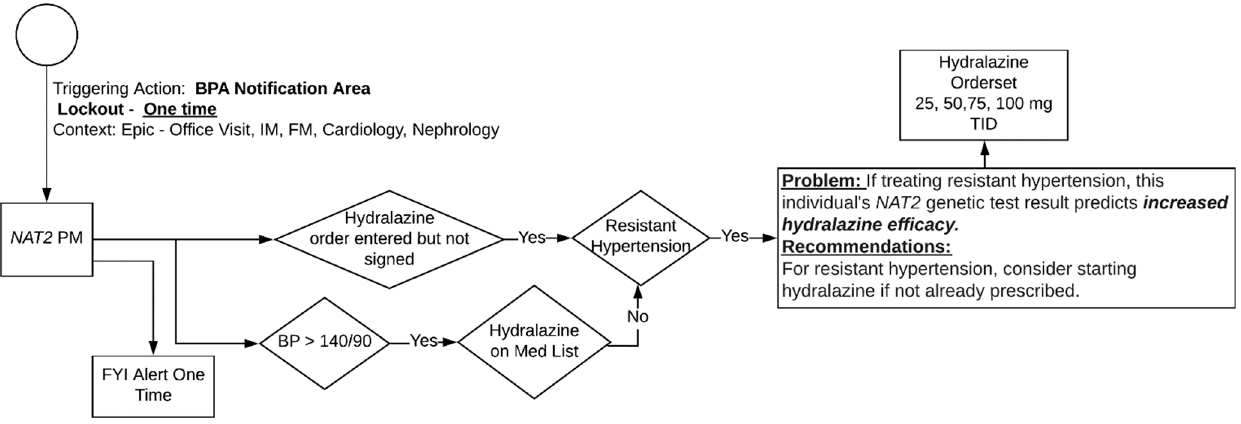
Figure A2. Proposed NAT2 algorithm for poor metabolizers. Table A1. List of institutions with associated clinical groups and EHR vendors. *—denotes sites who decided to manually release results to providers and therefore did not utilize the described CDS.